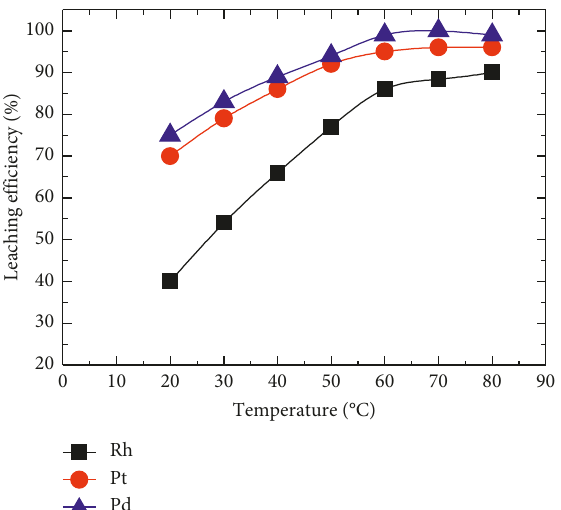
Figure 3: Effect of changing temperature on PGM leaching efficiencies using 0.8 vol% H